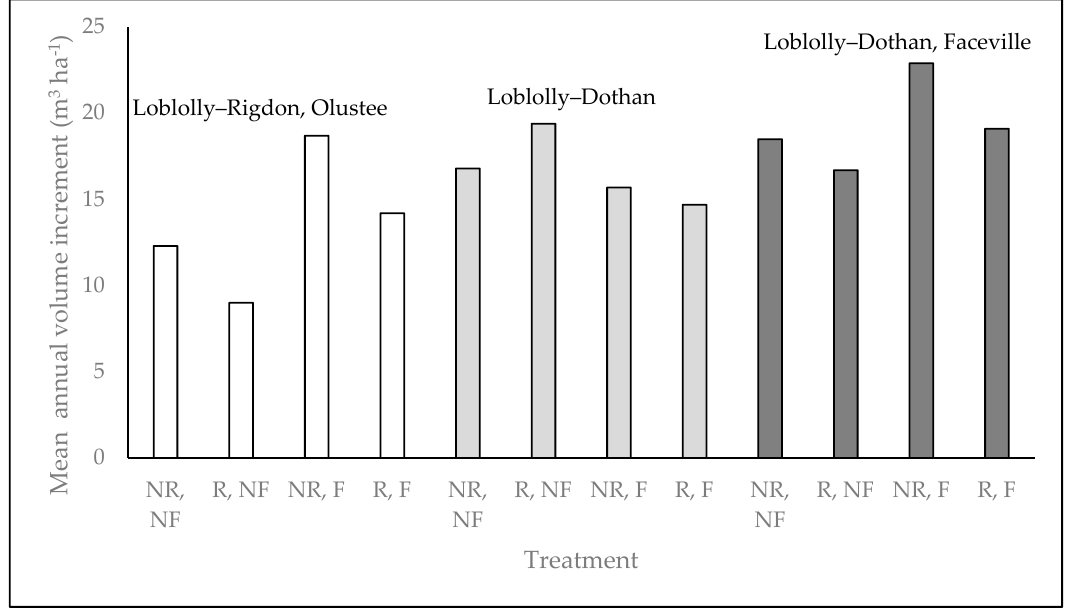
Figure 12. Mean annual volume ha growth over the five-year study period for three loblolly pine sites by treatment [25]. Treatments: no rake, no fertilization (NR, NF); rake, no fertilization (R, NF); no rake, fertilization (NR, F); rake, fertilize (R, F) (refer to Tables 6 and 7 for study details, information on fertilizer treatments, and statistical test results).